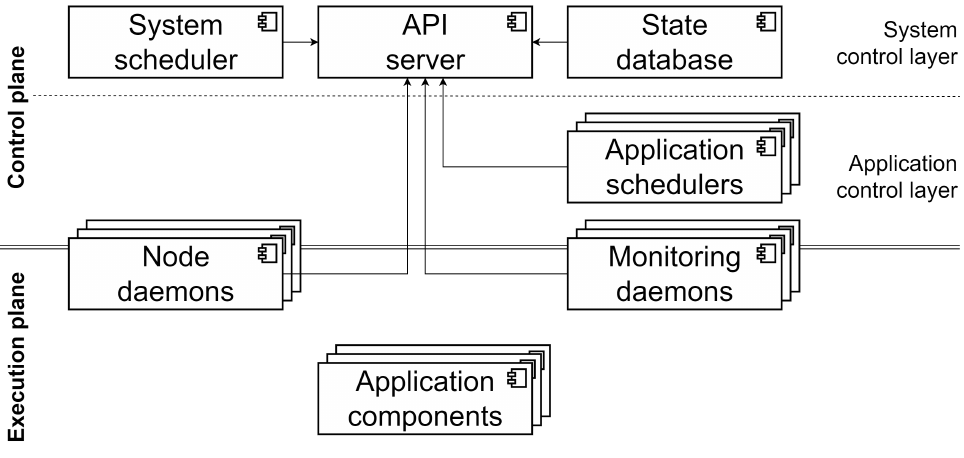
Figure 1. Architecture